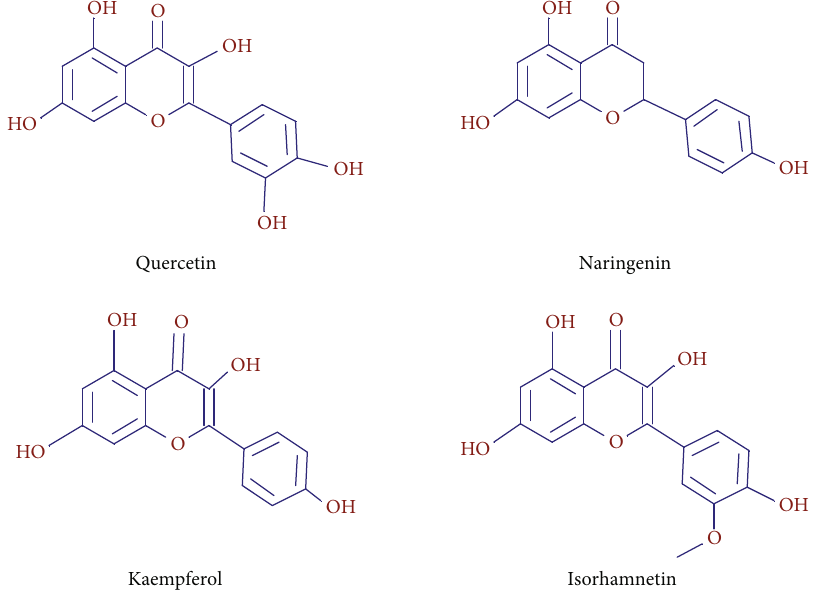
Figure 11: The chemical structures of quercetin, naringenin, kaempferol, and